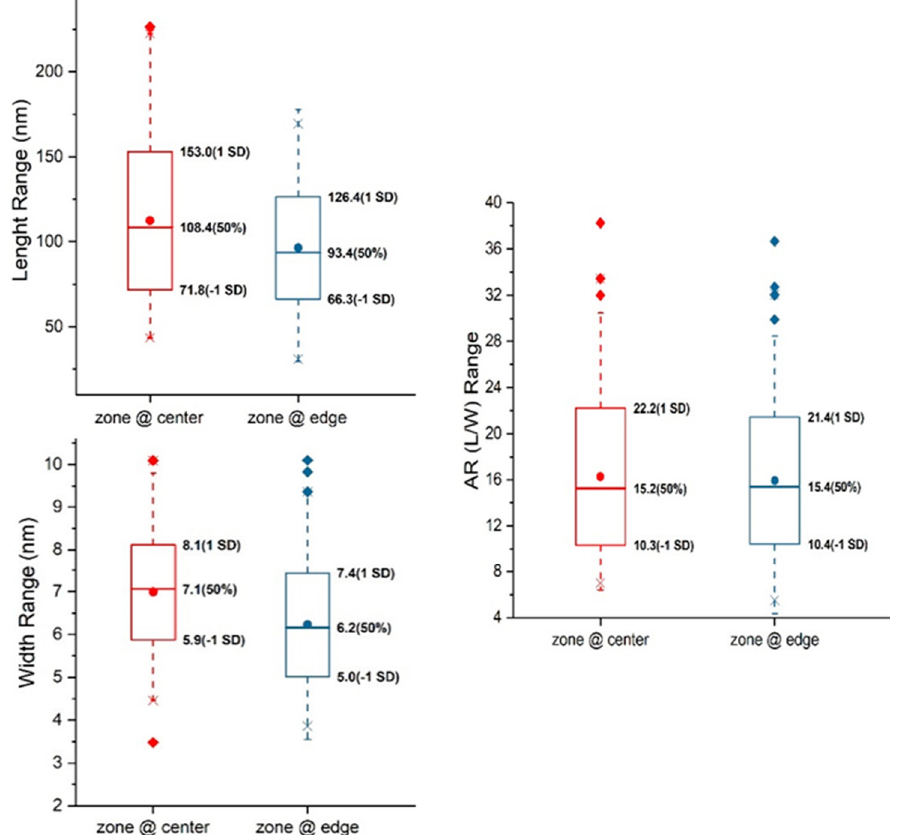
Figure 6. Box plots of length, width and aspect ratio (L/W) distribution of CNCs embedded in vitreous ice near the center and edge of TEM grids. The line and dot in the box is the median and mean, respectively. The values of the median and one standard deviation (SD) above and below the mean are labelled to the left of boxes.